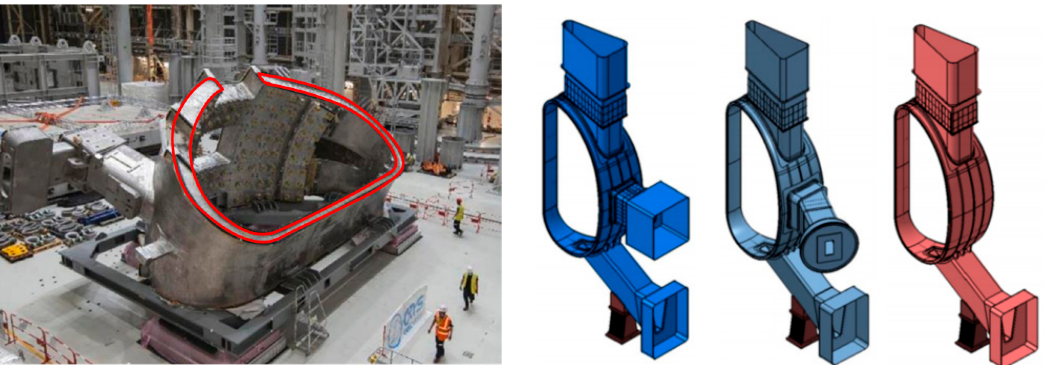
Figure 1. Prototype and model of the fan-shaped segments of the VV.